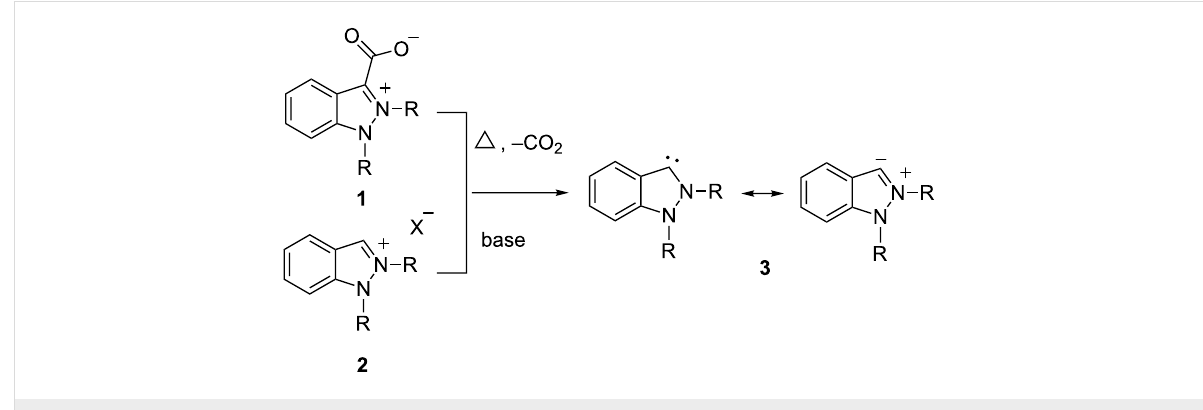
Scheme 1: Generation of